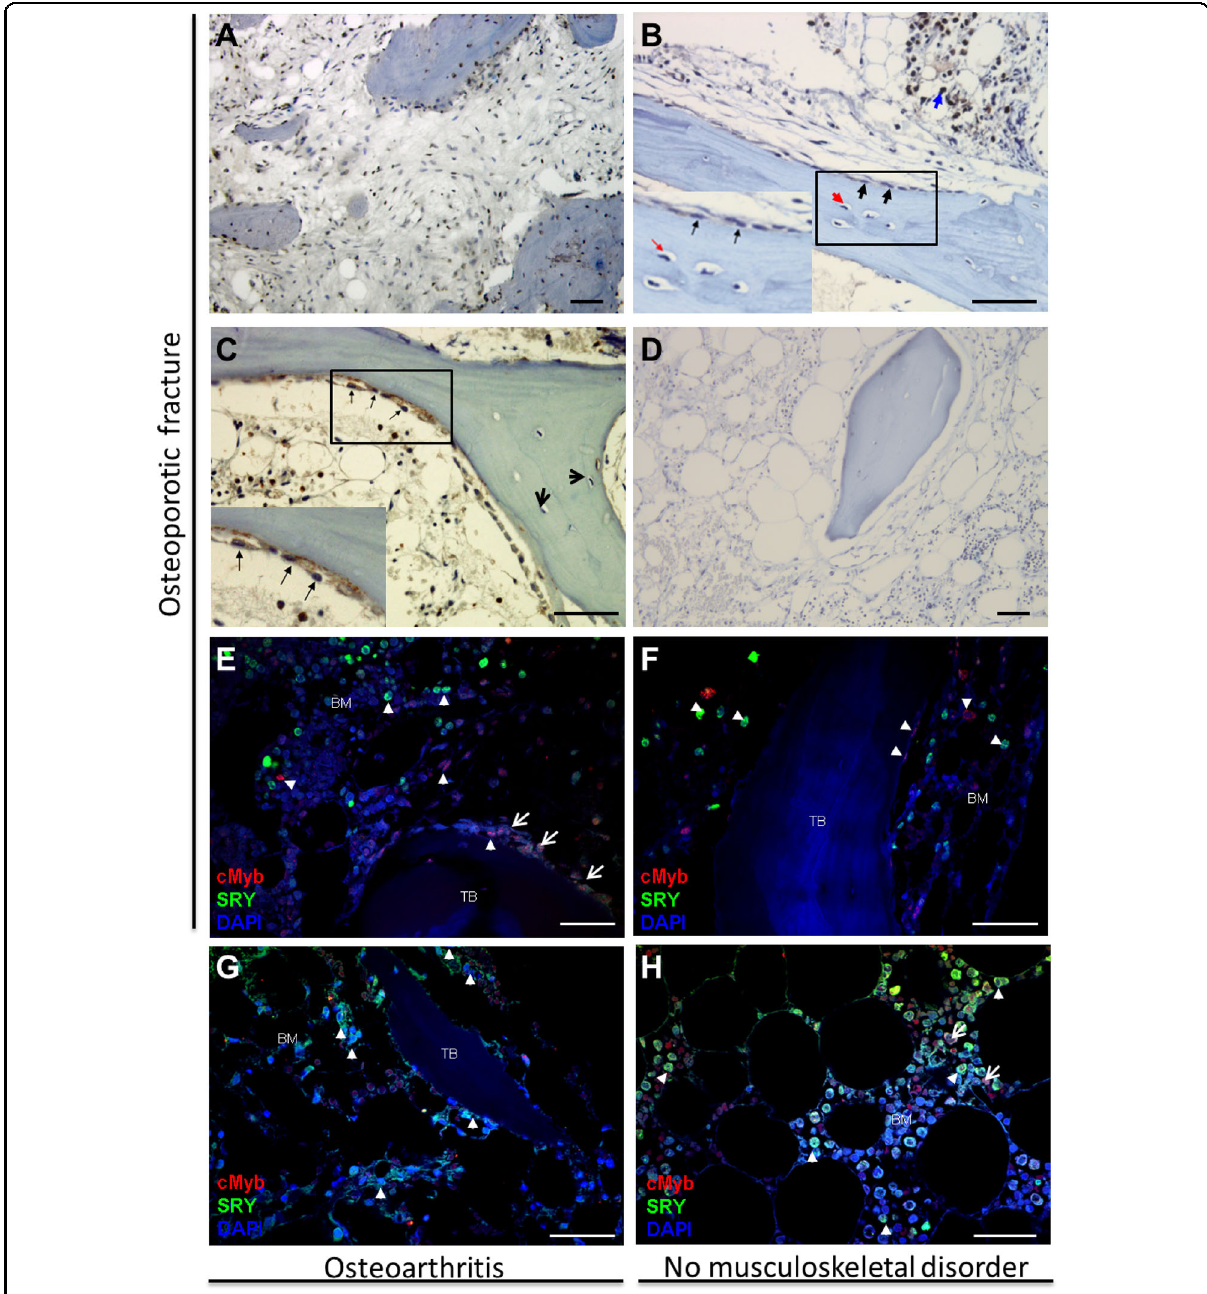
Fig. 5 Immunolocalization of cMyb and SRY in human bone tissue. a – c Bone tissue of a male patient with osteoporotic fracture. a cMyb staining is observed in the nuclei of lining cells, individual bone marrow cells, and osteocytes. b In inactive bone, SRY staining is observed in various cells of the bone marrow (blue arrow) and in the lining cells (black arrows), while osteocytes are negative for SRY (red arrow), similar to what was observed with cMyb. c In bone with active processes of bone remodeling, in addition to the cells in bone marrow, SRY was observed in active osteoblasts (closed arrows) and osteocytes (open arrows) just beneath the trabecular bone surface, which suggests its role in bone remodeling via RANKL. d No positive SRY staining was observed in female patients with osteoporotic fracture. e , f Bone tissue of a male patient with osteoporotic fractures showing costaining of cMyb and SRY in osteoblast-like cells (arrows) on the surface of trabecular bone ( e ); single-positive SRY or cMyb cells (arrowheads, e , f ) are present in bone marrow (BM); and cMyb single-positive cells are also present on the surface of trabecular bone (TB) ( e , f ). g , h Costaining for SRY and cMyb in bone tissue of a male patient with osteoarthritis ( g ) and in a male donor with no musculoskeletal disease ( h ) show similar patterns of localization; i.e., SRY single-positive cells (arrowheads) and SRY and cMyb double-positive cells (arrows) in bone marrow (BM). Immunohistochemistry ( a – d ) and double immuno fl uorescence ( e – h ) of human bone tissue. N = 3 donors per group (fracture, osteoarthritis and control group). Scale bars: 50